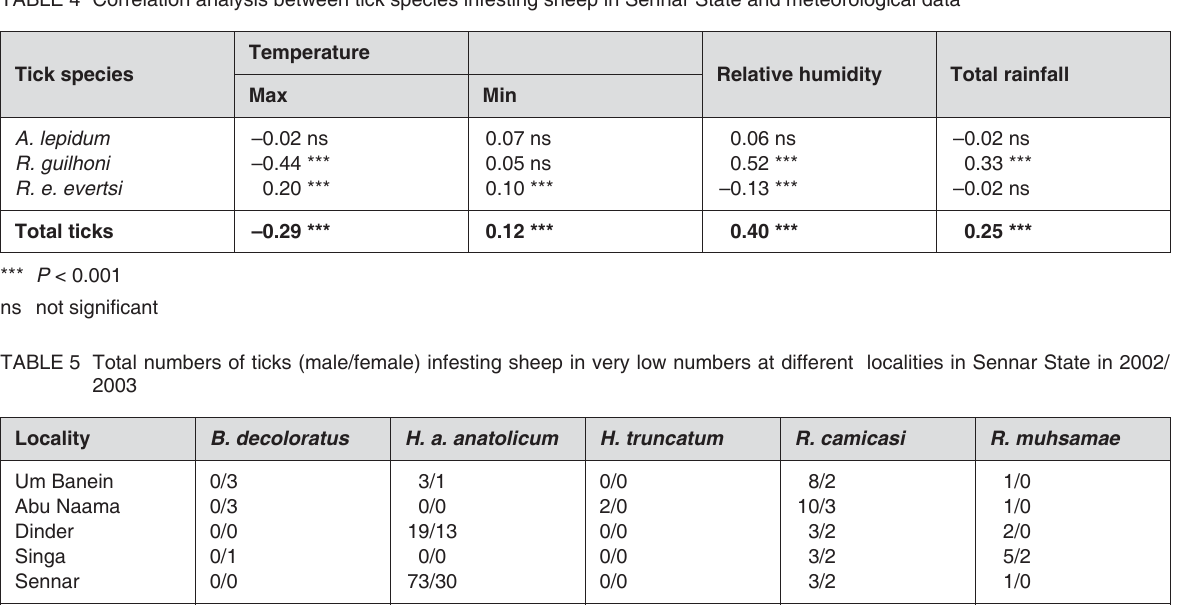
TABLE 4 Correlation analysis between tick species infesting sheep in Sennar State and meteorological data